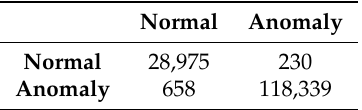
Table 13. Confusion matrix for Adaboost Reptree.